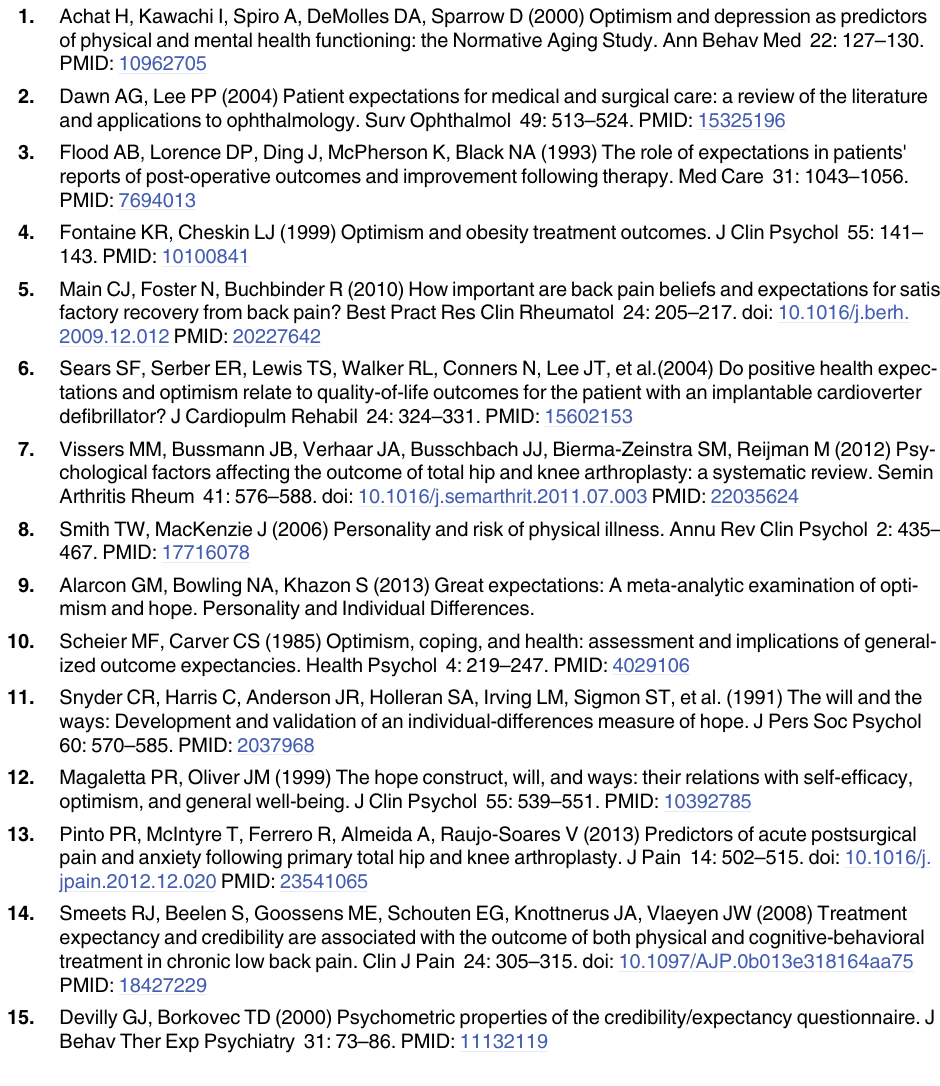
S3 Fig. Post-hoc model 3; the bifactor model. O1 — O3 = LOT-R optimism items 1 to 3,P1 — P3 = LOT-R reverse scored pessimism items 1 to 3,H1 — H8 = ADHS hope items 1 to 8,C1 — C3 = CEQ credibility items 1 to 3,E1 — E3 = CEQ expectancy items 1 to 3 ovals represent latent factors, squares represent observed